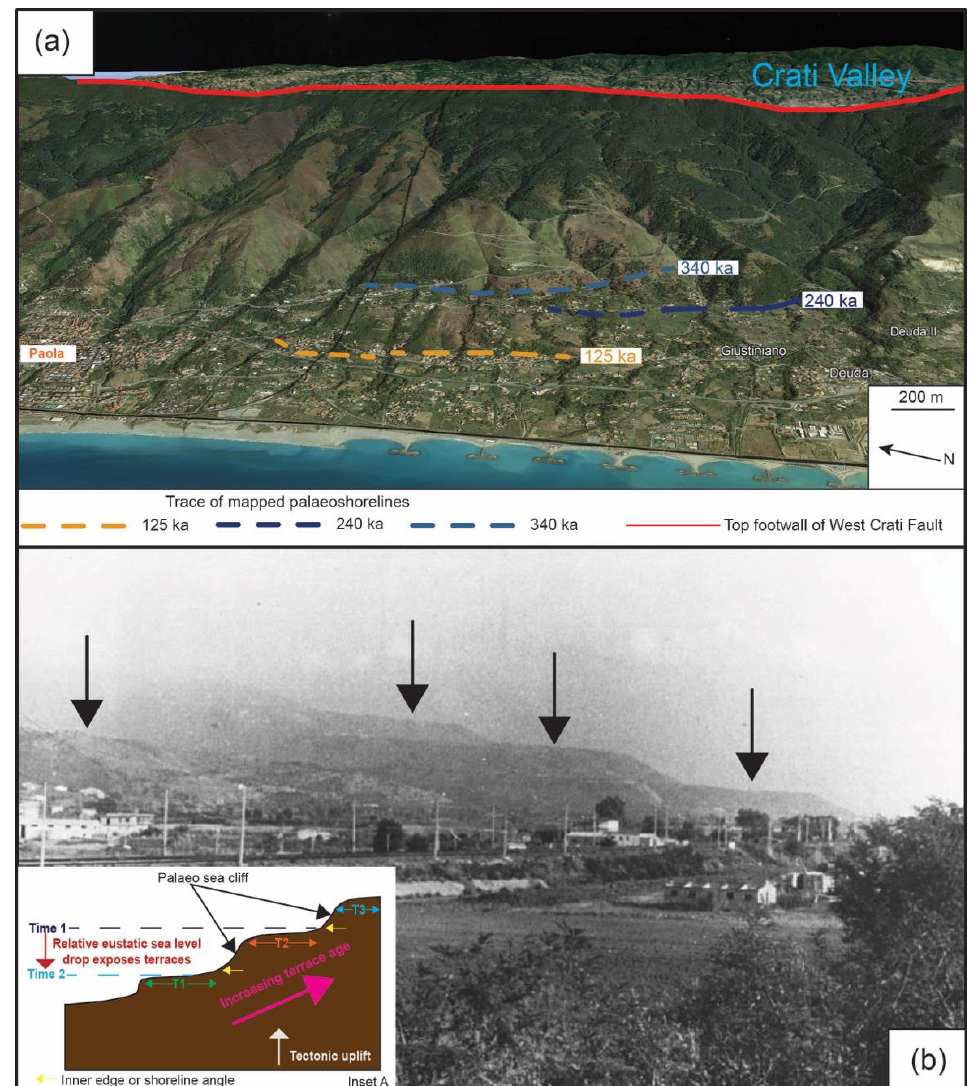
Figure 3. Evidence of raised marine terraces and their associated palaeoshorelines: in ( a ) three prom-inent sea-level highstands such as the 125 ka (MIS 5e), the 240 ka (MIS 7e), and the 340 ka (MIS 9e), which are mapped from Google Earth just south of Paola town, close to our Profile 11; in ( b ) a mod-ified photo taken from Westaway (1993), showing a sequence of marine terraces from field close to Profile 1, close to Coreca town. Inset A shows a sketch of conceptual evolution when marine terraces form.